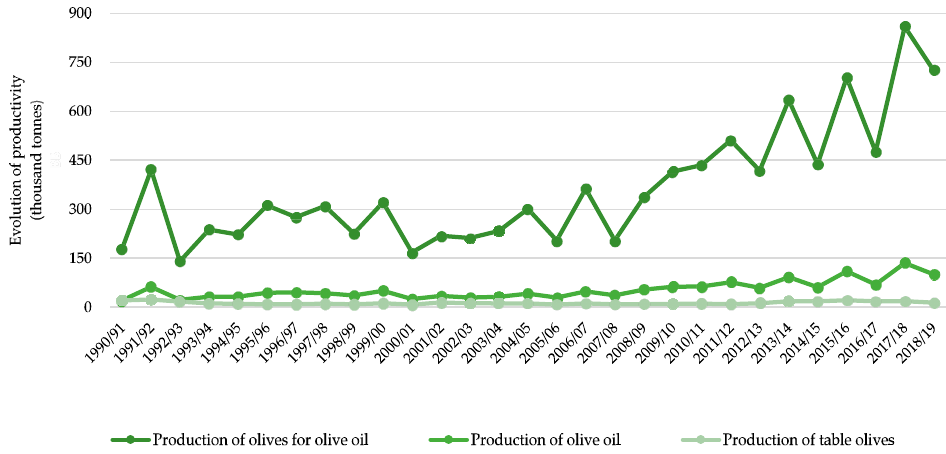
Figure 3. Evolution of production of olive oil and olives in the Portuguese olive sector since the 1990/1991 campaign year (data from IOC [10] and Instituto Nacional de Estatística (INE) [13]).